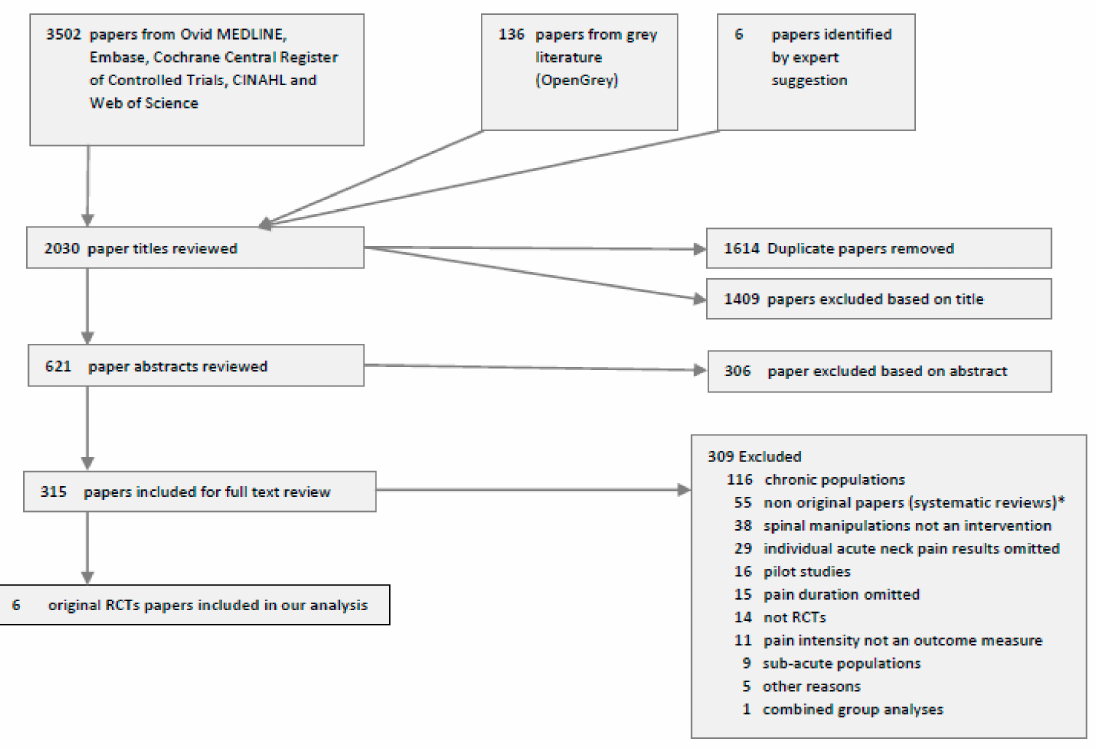
Figure 1. Flow chart of the literature search on acute neck pain RCT. * No original papers were retrieved from the systematic